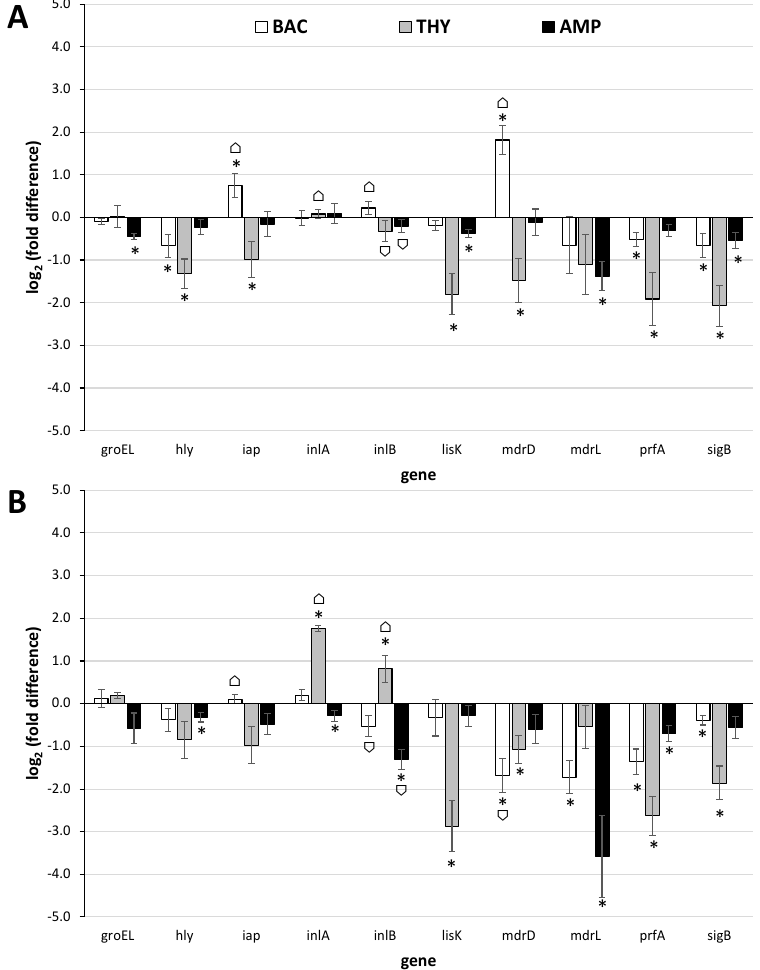
-5.0-4.0-3.0-2.0-1.00.01.02.03.04.05.0 ‐5.0‐4.0‐3.0‐2.0‐1.00.01.02.03.0 inlA inlB lisK Figure 1. Relative quantification (log 2 (fold differences)) of the expressions of the 10 target genes Figure 1. Relative quantification (log 2( fold differences)) of the expressions of the 10 target genes ( groEL , hly , iap , inlA , inlB , ( groEL , hly , iap , inlA , inlB , lisK , mdrD , mdrL , prfA , sigB ) at the 2 L. monocytogenes strains ( A ) AAL20066 Figure 1. Relative quantification (log 2( fold differences)) of the expressions of the 10 target genes ( groEL , hly , iap , inlA , inlB , Figure 1. Relative quantification (log 2( fold differences)) of the expressions of the 10 target genes ( groEL , hly , iap , inlA , inlB , Figure 1. Relative quantification (log 2( fold differences)) of the expressions of the 10 target genes ( groEL , hly , iap , inlA , inlB , lisK , mdrD , mdrL , prfA , sigB ) at the 2 L. monocytogenes strains ( A ) AAL20066 (ser. 1/2a) and ( B ) AAL20074 (ser. 4b), following (ser. 1/2a) and ( B ) AAL20074 (ser. 4b), following their sublethal exposure (for 2 h at 37 ◦ C) to BAC lisK , mdrD , mdrL , prfA , sigB ) at the 2 L. monocytogenes strains ( A ) AAL20066 (ser. 1/2a) and ( B ) AAL20074 (ser. 4b), following lisK , mdrD , mdrL , prfA , sigB ) at the 2 L. monocytogenes strains ( A ) AAL20066 (ser. 1/2a) and ( B ) AAL20074 (ser. 4b), following lisK , mdrD , mdrL , prfA , sigB ) at the 2 L. monocytogenes strains ( A ) AAL20066 (ser. 1/2a) and ( B ) AAL20074 (ser. 4b), following their sublethal exposure (for 2 h at 37 °C) to BAC (4.0 μ g/mL; □ ), THY (312.5 μ g/mL; ) or AMP (0.5 μ g/mL; ), in com- (4.0 µ g/mL; (cid:3) ), THY (312.5 µ g/mL; ), in comparison to the untreated their sublethal exposure (for 2 h at 37 °C) to BAC (4.0 μ g/mL; □ ), THY (312.5 μ g/mL; ) or AMP (0.5 μ g/mL; ), in com- their sublethal exposure (for 2 h at 37 °C) to BAC (4.0 μ g/mL; □ ), THY (312.5 μ g/mL; ) or AMP (0.5 μ g/mL; ), in com- their sublethal exposure (for 2 h at 37 °C) to BAC (4.0 μ g/mL; □ ), THY (312.5 μ g/mL; ) or AMP (0.5 μ g/mL; ), in com ‐ parison to the untreated controls (no antimicrobial exposure). Each bar represents the mean ± standard errors ( n = 9). The parison to the untreated controls (no antimicrobial exposure). Each bar represents the mean ± standard errors ( n = 9). The parison to the untreated controls (no antimicrobial exposure). Each bar represents the mean ± standard errors ( n = 9). The controls (no antimicrobial exposure). Each bar represents the mean ± standard errors ( n = 9). The parison to the untreated controls (no antimicrobial exposure). Each bar represents the mean ± standard errors ( n = 9). The statistically significant differences in genes’ expressions relative to the controls appear as asterisks (*) above the bars, while statistically significant differences in genes’ expressions relative to the controls appear as asterisks (*) above the bars, while statistically significant differences in genes’ expressions relative to the controls appear as asterisks (*) above the bars, while statistically significant differences in genes’ expressions relative to the controls appear as asterisks (*) statistically significant differences in genes’ expressions relative to the controls appear as asterisks (*) above the bars, while ⌂ denote the statistically significant differences in genes’ expressions between the two strains ( P < 0.05). ⌂ denote ⌂ denote the statistically significant differences in genes’ expressions between the two strains ( P < 0.05). the statistically significant differences in genes’ expressions between the two strains ( P < 0.05). ⌂ denote the statistically significant differences in genes’ expressions between the two strains ( P < 0.05). above the bars, while denote the statistically significant differences in genes’ expressions between the two strains ( p < Another gene with similar significant upregulation was that coding for the multidrug resistance transporter MdrD in ser. 1/2a strain following its exposure to BAC (Figure 1A). The expression of that gene was previously found to be significantly upregulated in L.